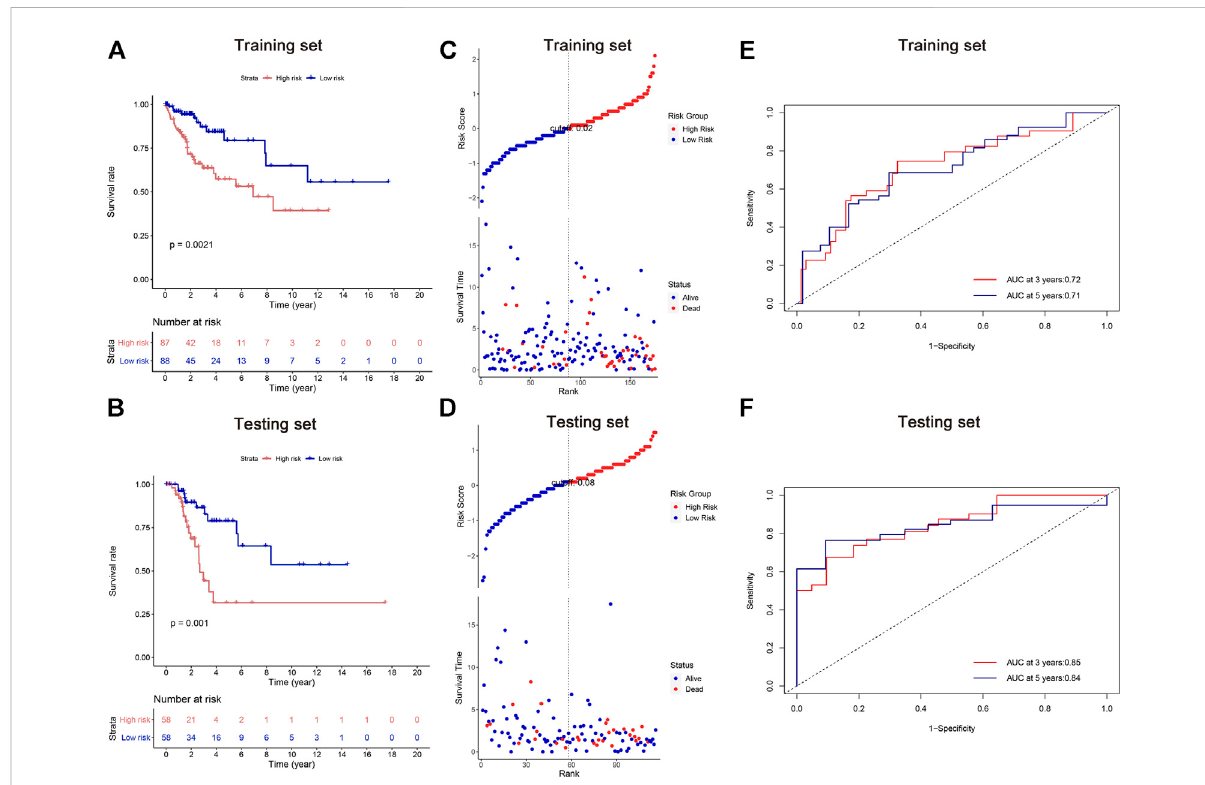
FIGURE 3 Survival analysis of cervical cancer patients in the training and testing sets. (A,B) Kaplan-Meier methods; (C,D) the distributions of risk scores, patient status, and survival time; (E,F) the receiver operating characteristic (ROC) analysis. The area under theROCs (AUCs) were assessedfor 3-year and 5-year